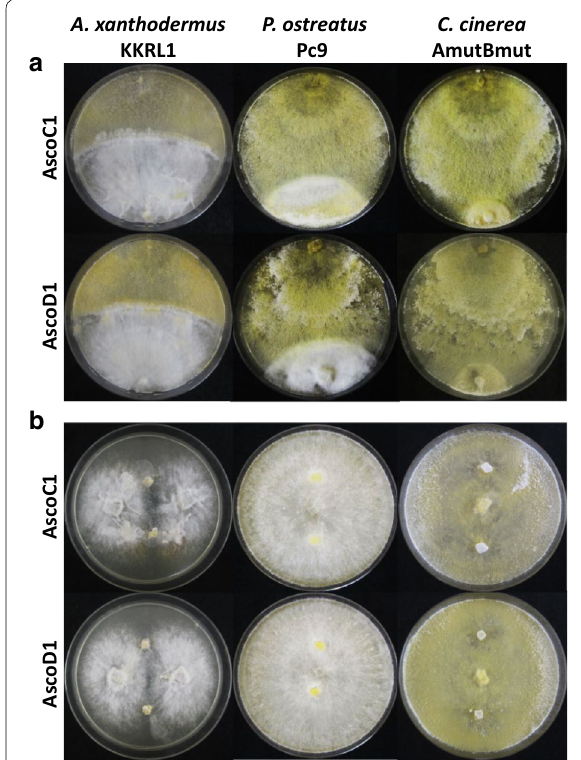
Fig. 9 Mycelial growth confrontation tests (top rows) and grown mycelium challenge tests (bottom rows) of A. xanthodermus KKRL1, P. ostreatus Pc9 and C. cinerea AmutBmut by H. odoratus isolates on MEA, photographed after 20 days of incubation at RT